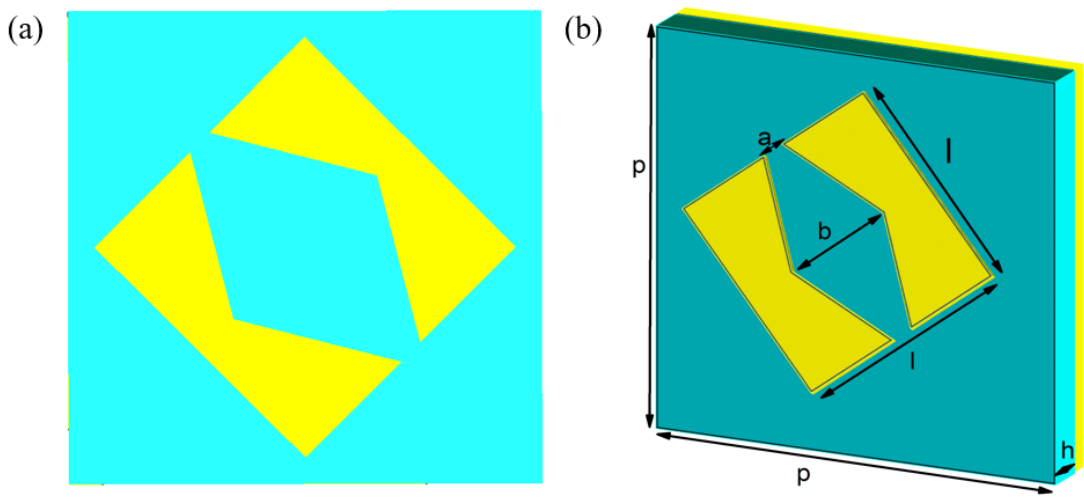
Figure 1. Schematic diagram of the proposed meta − unit cell structure: ( a ) front view, ( b ) side view.